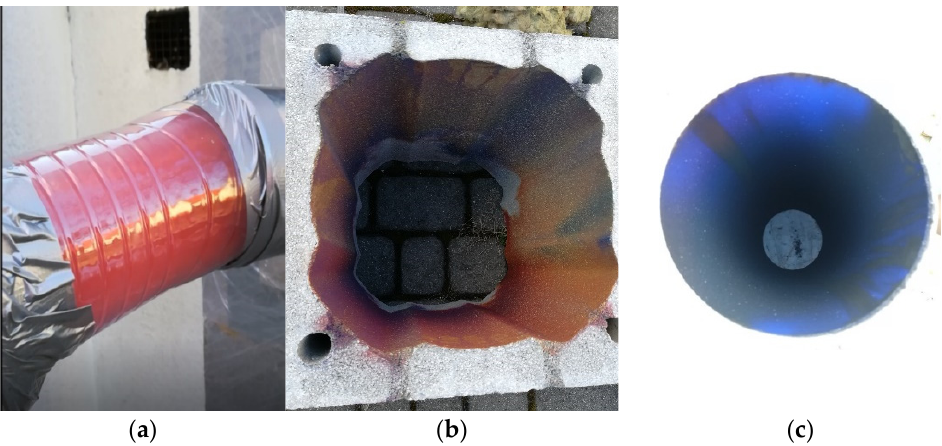
Figure 9. View of ( a ) transparent control point at the inlet of the air to the stove, ( b ) coloured structure of the air duct (red) and ( c ) coloured flue (blue).